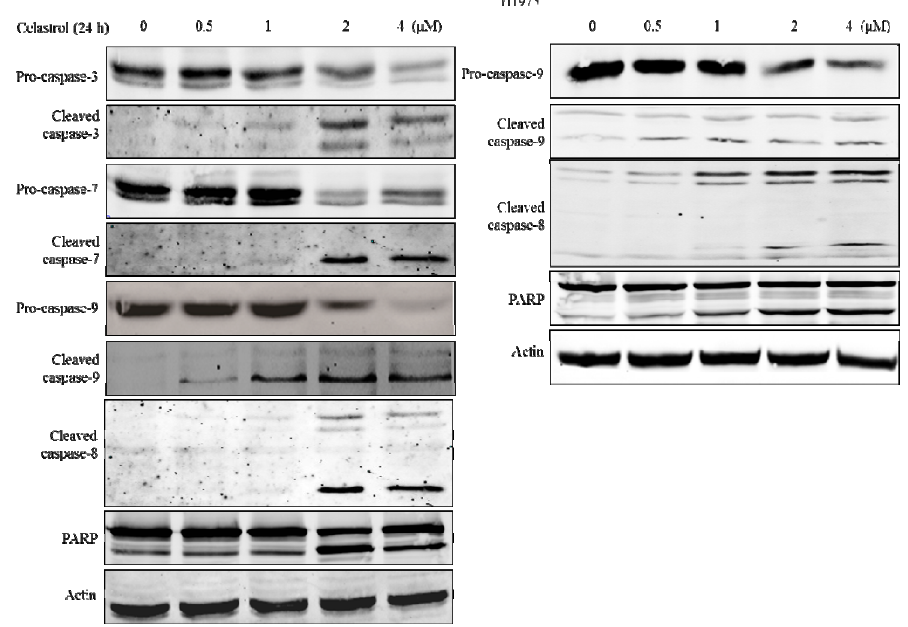
Figure 4. Effect of celastrol on the activation of caspase 3, 7, 8, 9 and PARP was detected at 24 h after the treatment of celastrol, and β - actin was considered as a loading control. Left panel showed the Western blot results of H1650, and the right panel showed the Western blot results of H1975.